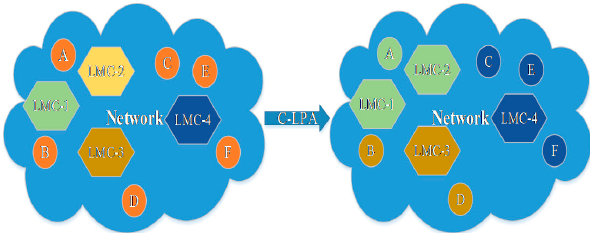
Figure 4. Illustration of the C-LPA. (1) Assign each LMC a unique label and allocate a random label to the other nodes; (2) Start the label propagation and detect the communities. For the CD-SHA, we defined the structural holes (SHs) to satisfy Equation (5) and across communities; s represents the CD-score.